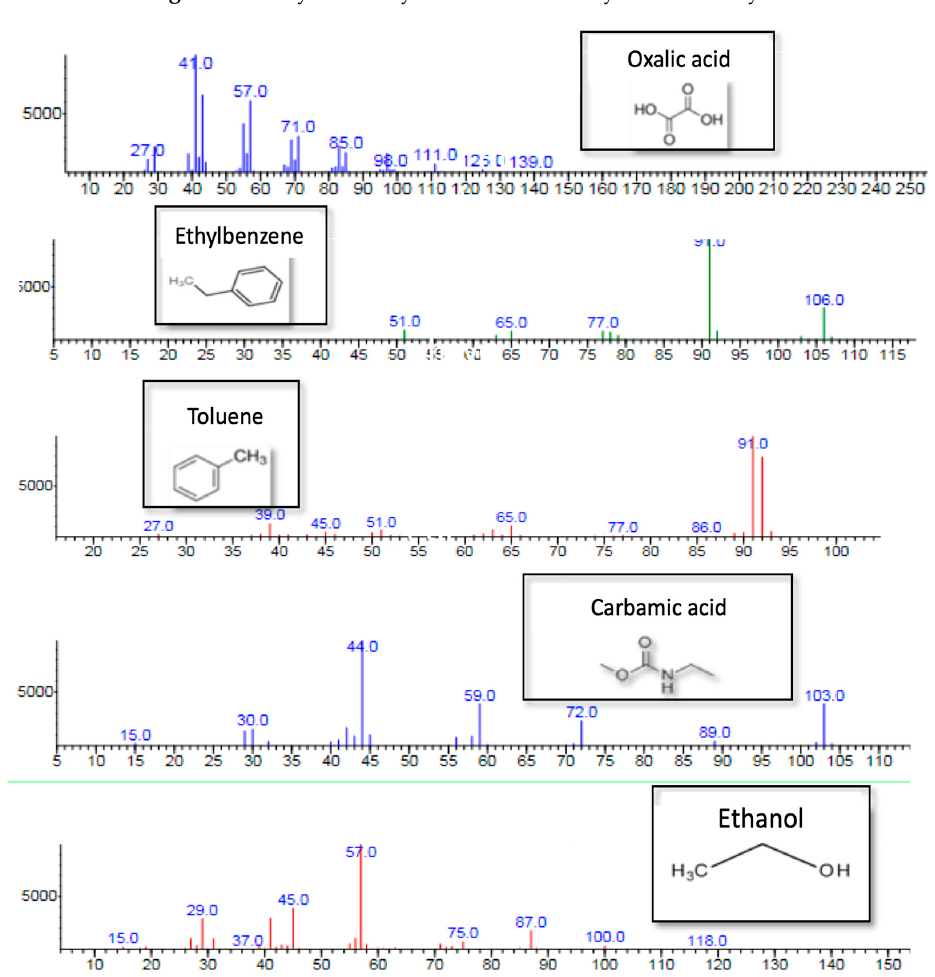
Figure 6. GC-MS chromatogram for CWPO in CV after 80 min of reaction.